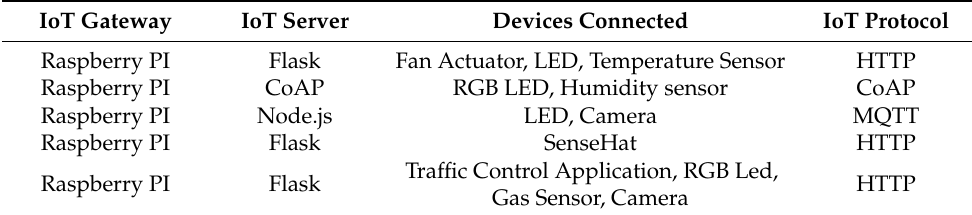
Table 6. Specification of implementation environment of application